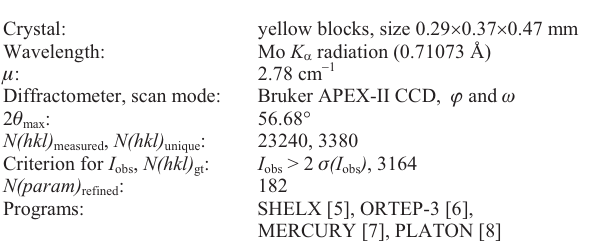
Table 1. Data collection and